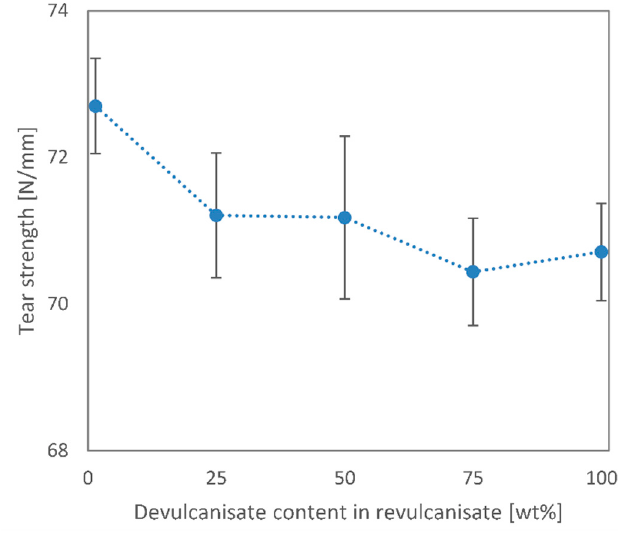
Figure 7. Shore A hardness of EPDM revulcanisates vs. devulcanisate content.